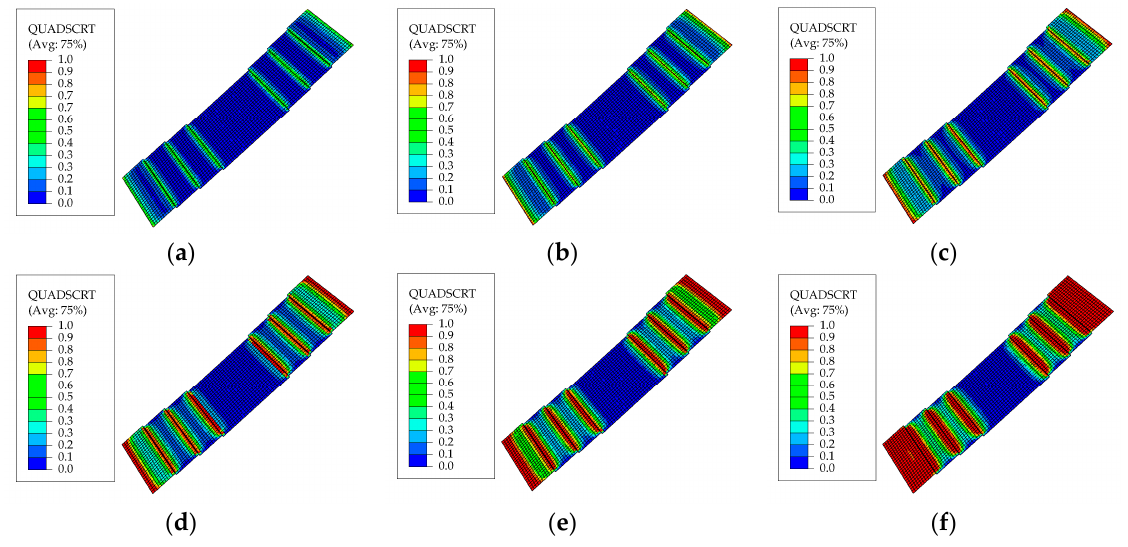
Figure 10. Damage evolution of stepped-lap joint surface: ( a ) F = 30.5 kN; ( b ) F = 37.4 kN; ( c ) F = 44.3 kN; ( d ) F = 50.9 kN; ( e ) F = 56.9 kN; ( f ) F = 63.1 kN.